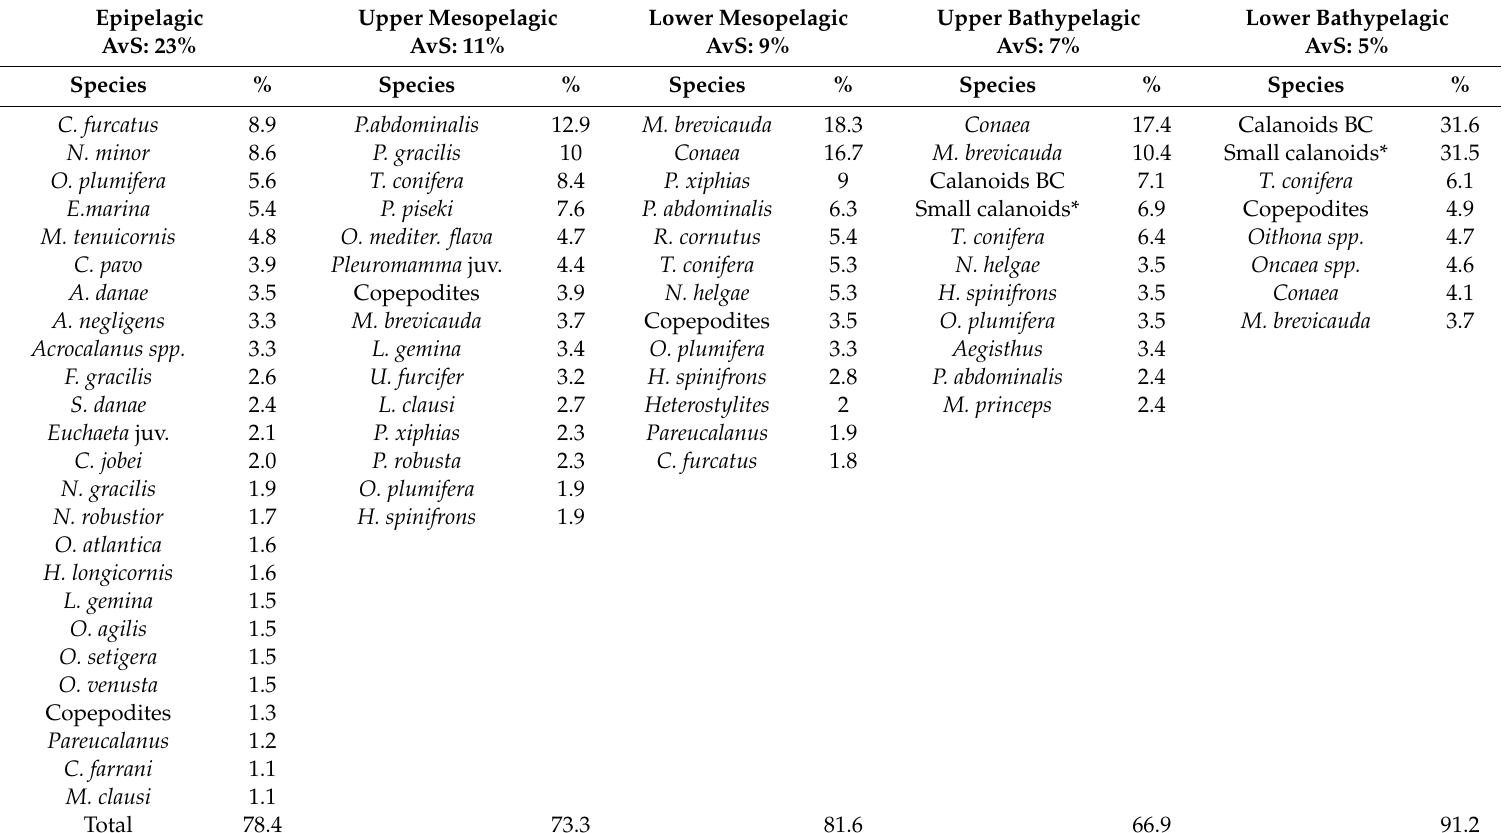
Table 5. Copepod contribution taxa to the di ff erent strata (%). AvS stands for Average Similarity, Copepodites for juvenile Calanoids, and BC for organisms in bad conditions. Small calanoids * ( Paracalanus, Clausocalanus, Calocalanus, Acartia ) were possible